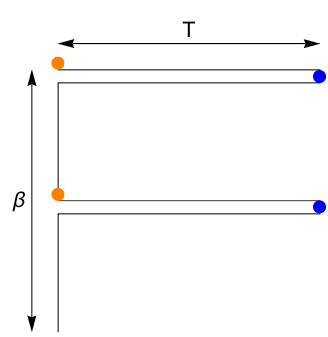
Figure 1. Schwinger-Keldysh contour for ˜ C ( T ) for the special case t 0 = 0